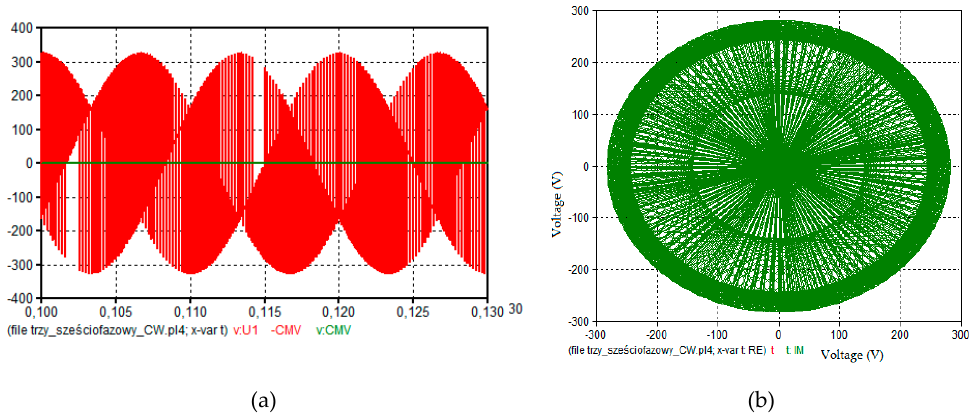
Figure 5. Waveforms of the output voltages (red lines) and the CMV (green lines) ( a ) and trajectory of the output voltage ( b ), synthesized in the MC controlled by the use of the CCW rotating space vectors, for six ‐ phase load and output frequency of 30 Hz.